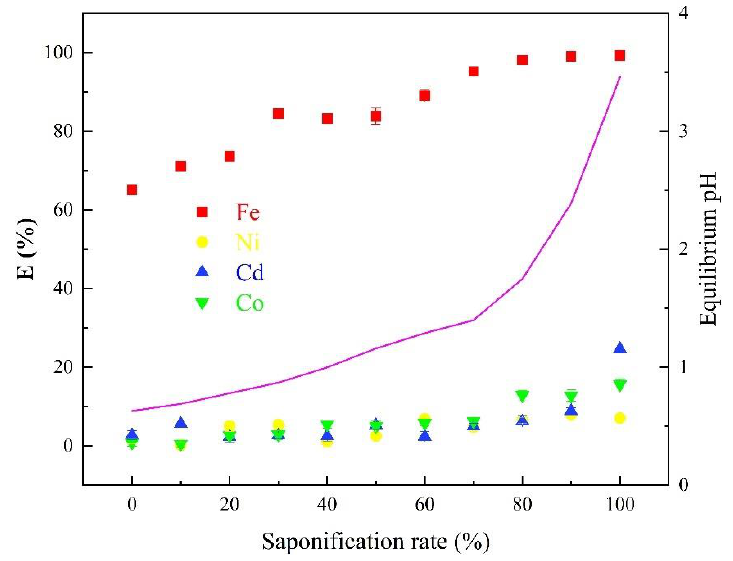
Figure 2. Effects of D2EHPA saponification rate on the extraction under the conditions: room temperature (298 K), [D2EHPA] = 1 mol/L, initial [Fe 3+ ] = 12.25 g/L, extraction time = 20 min, initial pH = 1.00, and phase ratio = 1:1.